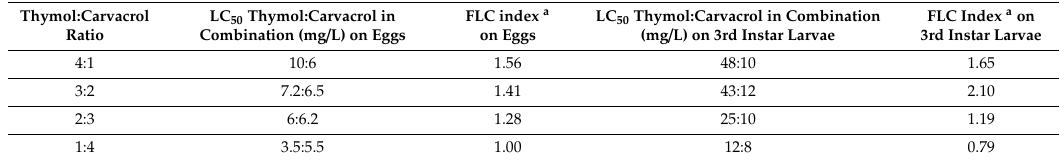
Table 2. Ovicidal and larvicidal results achieved on Culex pipiens testing carvacrol-thymol combinations with the fixed ratio method.